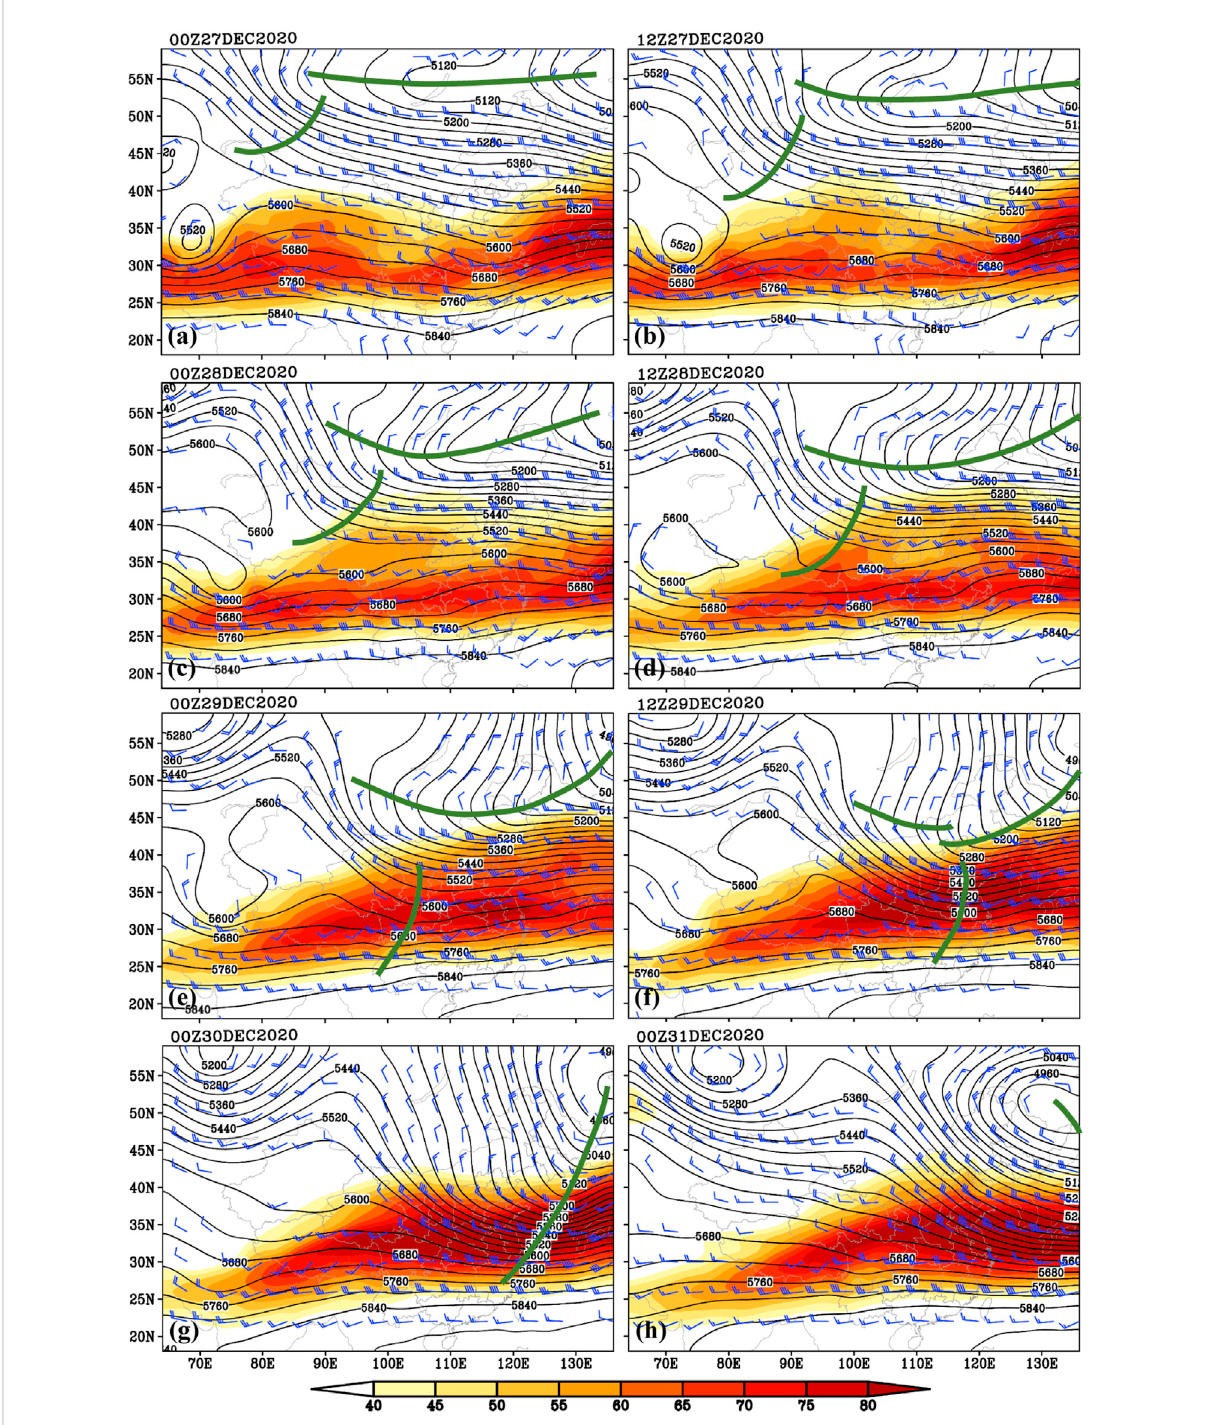
FIGURE 3 Geopotential height (black contours; gpm) and wind > 10 m s − 1 (full bar = 10 m s − 1 ) at 500 hPa, and wind speed at 200 hPa (shading; m s − 1 ). Green lines = trough